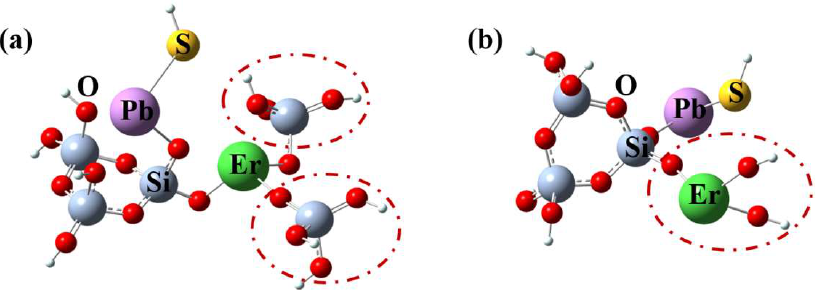
Figure 3. Local structural models of PbS/Er co-doped 3MR. ( a ) Er connected with two Si tetrahedrons; ( b ) Er connected with two BOs.